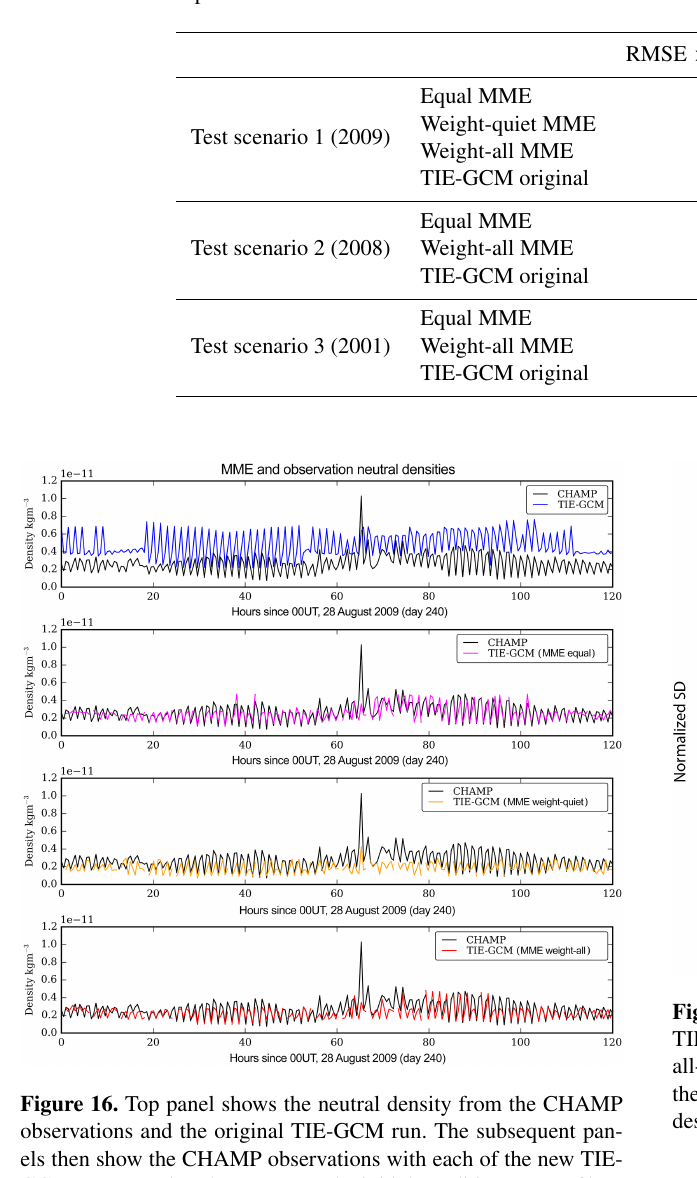
Table 4. The RMSE of the original TIE-GCM run and running the model with the MME as the initial conditions. The 95% confidence intervals are also reported.